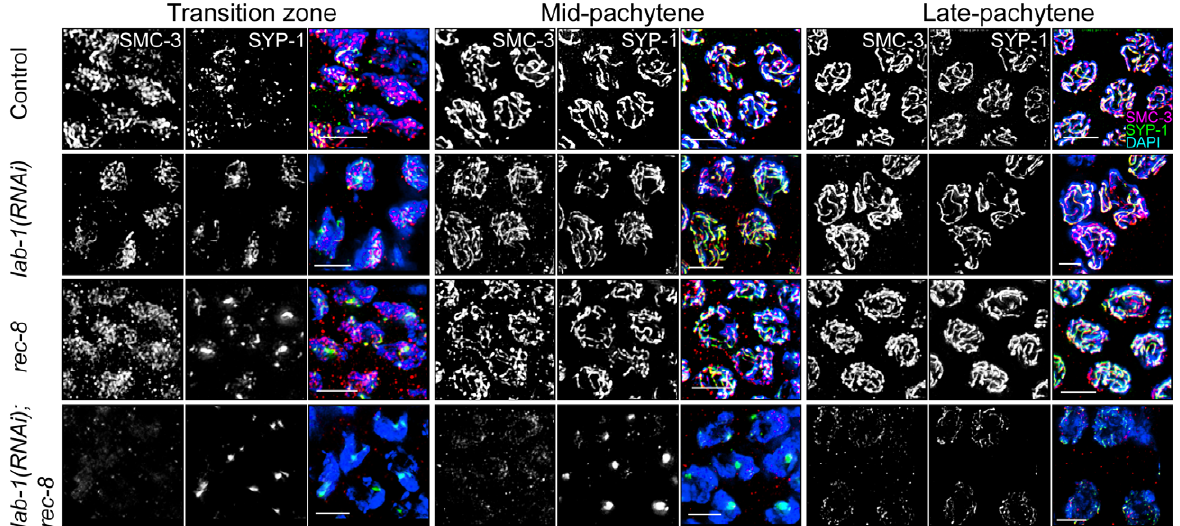
Figure 4. Both LAB-1 and REC-8 are required for SMC-3 and SYP-1 localization onto chromosomes. Transition zone, mid-pachytene, and late pachytene nuclei in the germlines of the indicated genotypes co-stained with SMC-3 (red), SYP-1 (green), and DAPI (blue). Bars, 4 m M.